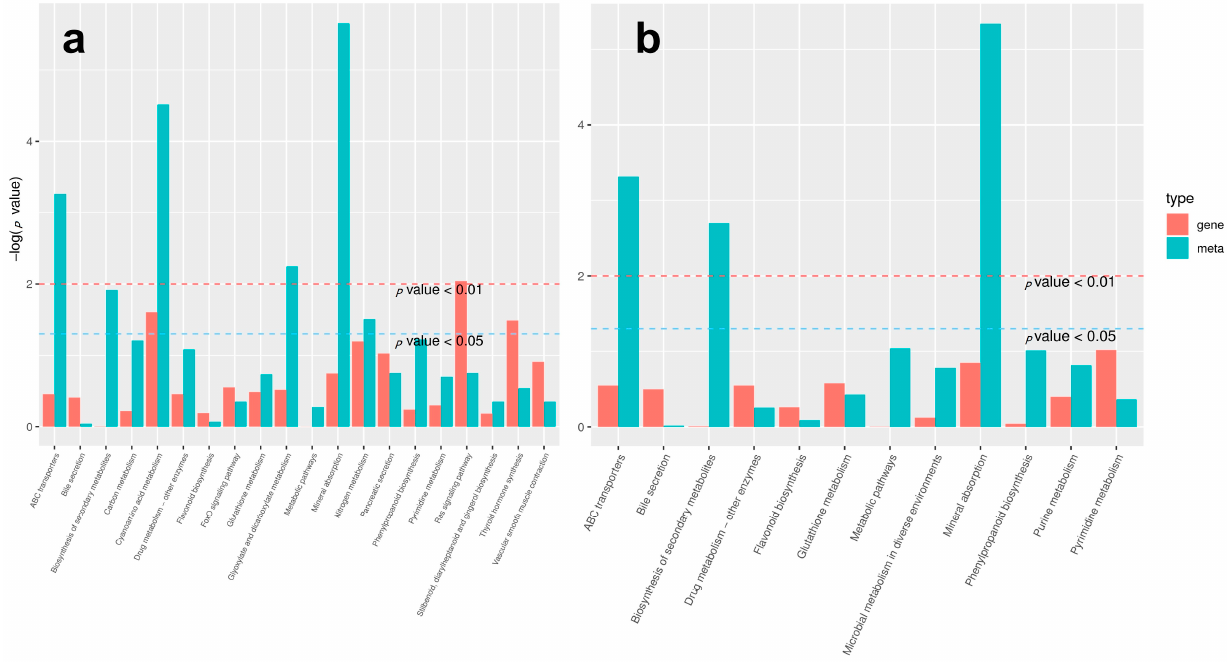
Figure 6. Enrichment map of differential metabolites and differential genes in mix flower buds of chestnut. ( a ) The CMF in pre- and post-winter; ( b ) The IMF in pre- and post-winter. Thirty-four metabolites were obtained by comparing the CMF metabolome with the IMF metabolome in pre- and post-winter. Comparing the CMF transcriptome with the IMF transcriptome in pre- and post-winter, 686 genes were obtained by eliminating the same differential genes. The correlation analysis was carried out between these metabolites and genes. The correlation network diagram was established based on metabolites and genes as metabolism. They jointly participated in the Phytohormones signal transmission signal pathway (Figure 7). In this pathway, metabolites and genes were up-regulated, which was a positive